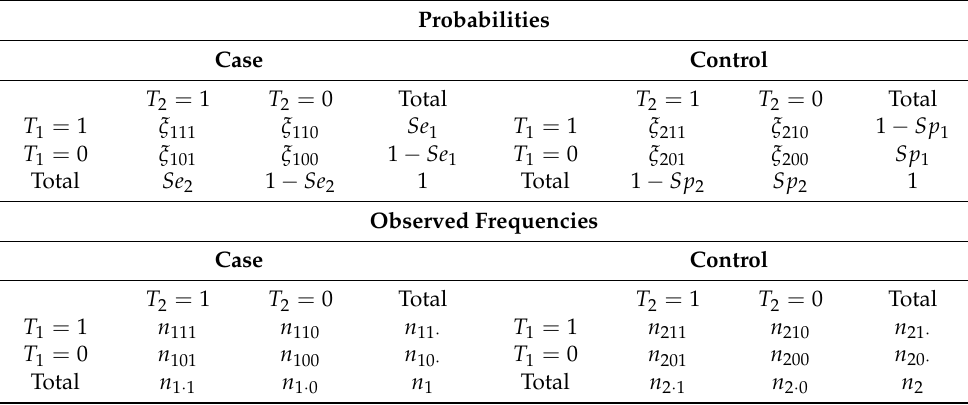
Table 1. Probabilities and observed frequencies subject to case-control